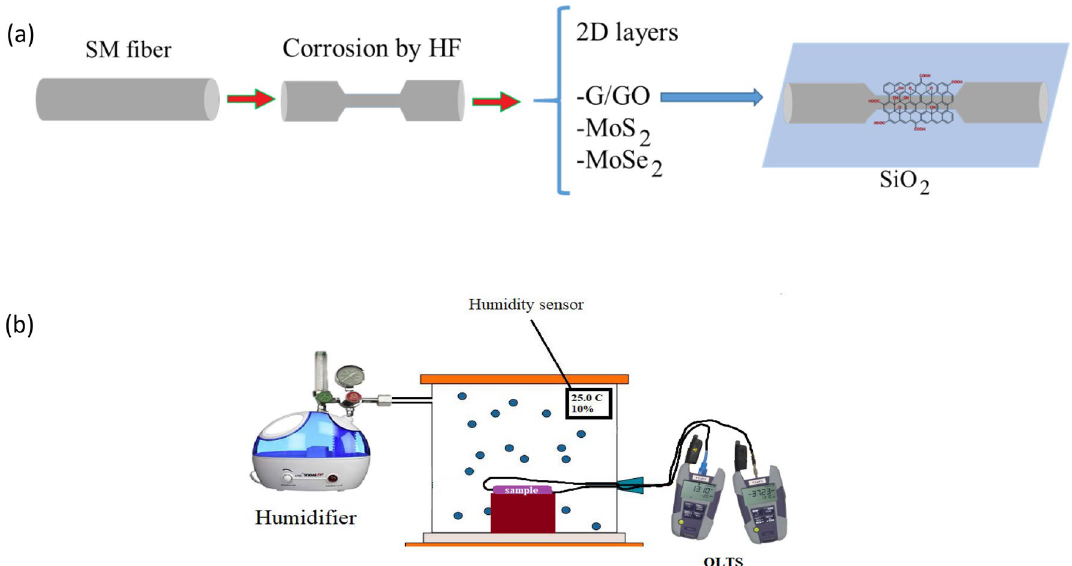
Figure 5. Schematic preparation of (a) optical fiber for humidity sensing and (b) the setup of the humidity sensing